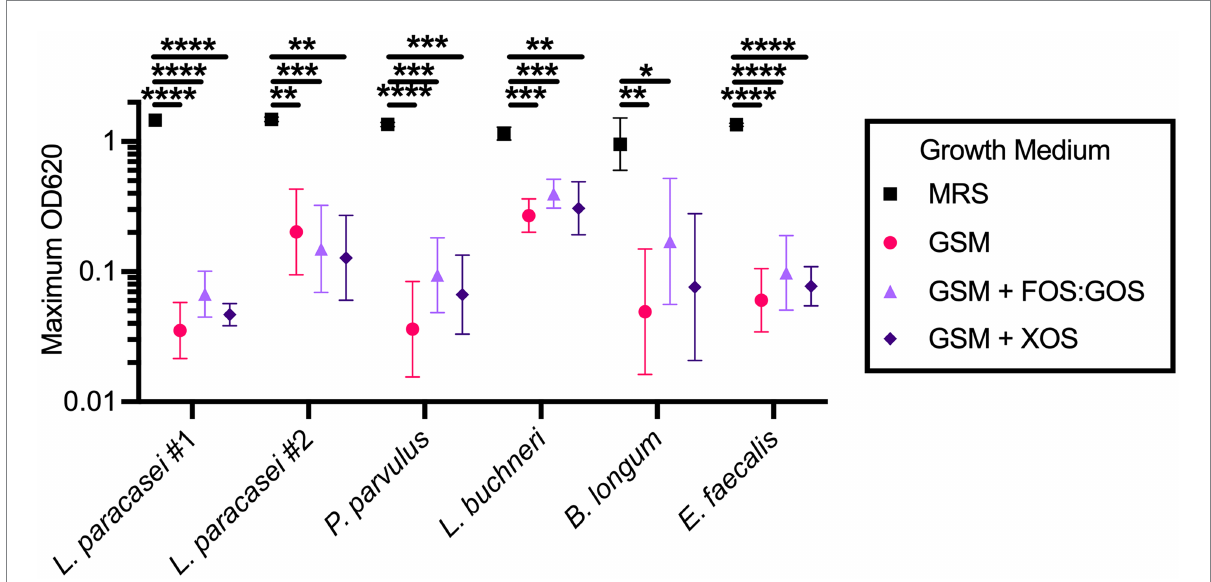
FIGURE 5 Sauerkraut Lactobacillaceae isolates grow in GSM. Four Lactobacillaceae strains isolated from sauerkraut brine ( Lactobacillus paracasei #1 and #2, Pediococcus parvulus , Lactobacillus buchneri ) and two fecal strains isolated under Lactobacillaceae selective conditions ( Bifidobacterium longum and Enterococcus faecalis ) were grown anaerobically in the indicated media. Data represents geometric mean ± geometric SD. All comparisons between growth media within an isolate with p -values <0.05 are reported. * p < 0.05, ** p < 0.01, *** p < 0.005, **** p <